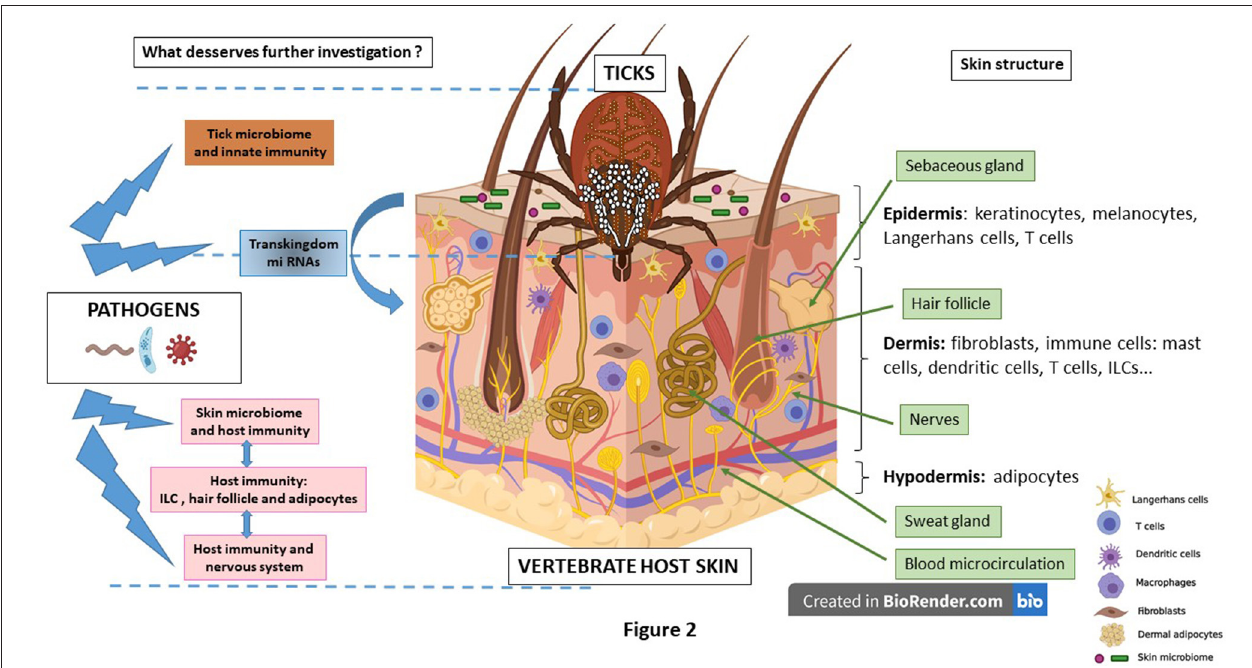
FIGURE 2 | The skin is structured into three interconnected layers. The epidermis, the uppermost layer, mainly composed of keratinocytes accompanied by immune cells such as Langerhans cells and T cells. On its surface, the skin microbiome (bacteria, yeasts and virus) plays a key role in skin homeostasis. The dermis is responsible for resistance and elasticity of the skin. Dermal resident cells are fibroblasts secreting extracellular matrix with numerous immune cells such as dendritic cells, T cells, mast cells, Innate Lymphoid cells (ILCs) and others. Different appendages are present: hair follicles surrounded by dermal adipocytes, sweat glands, microcirculation blood vessels, nerves and sebaceous glands. Then beneath the dermis is the hypodermis that contains numerous adipocytes. During the process of an ixodid, hard tick bite, a feeding pool develops around the tick mouthparts. Saliva is introduced into the bite site and modulates the local host immune response with the goal of avoiding tick rejection. The tick microbiome can be secreted into the skin as exosomes. Likely, transkingdom miRNAs participate in the regulation of the infection. The role of skin immunity and skin and tick microbiomes deserves to be better investigated during the process of pathogen inoculation, multiplication and persistence. Some immune privileged sites like the hair follicle and the adipocytes might help pathogens to better survive within the skin. Recently, the potential role of nerves in the skin immune regulation has been evoked. Created with